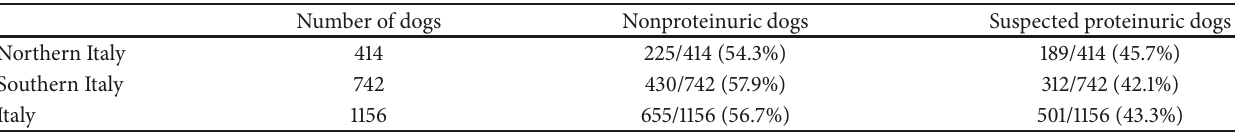
Table 1: Dogs classified as non- or suspected proteinuricon the basis of the screening carried out with reactive strip for urine. In this table the absolutenumbersforgeographicaldistributionandtherelativepercentagestofacilitatethecomparisonofresultsforthedifferentgeographical areas are